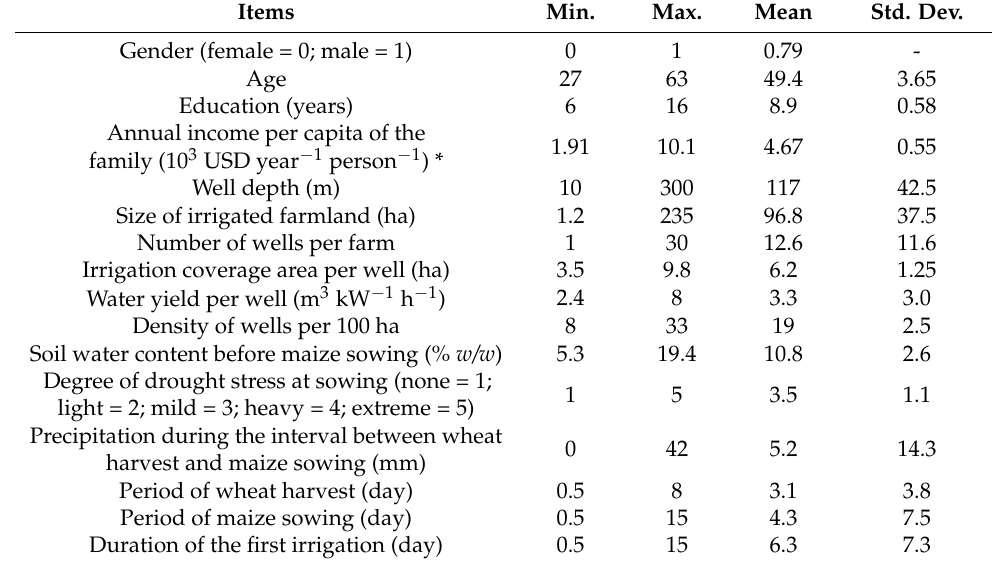
Table 1. Summary